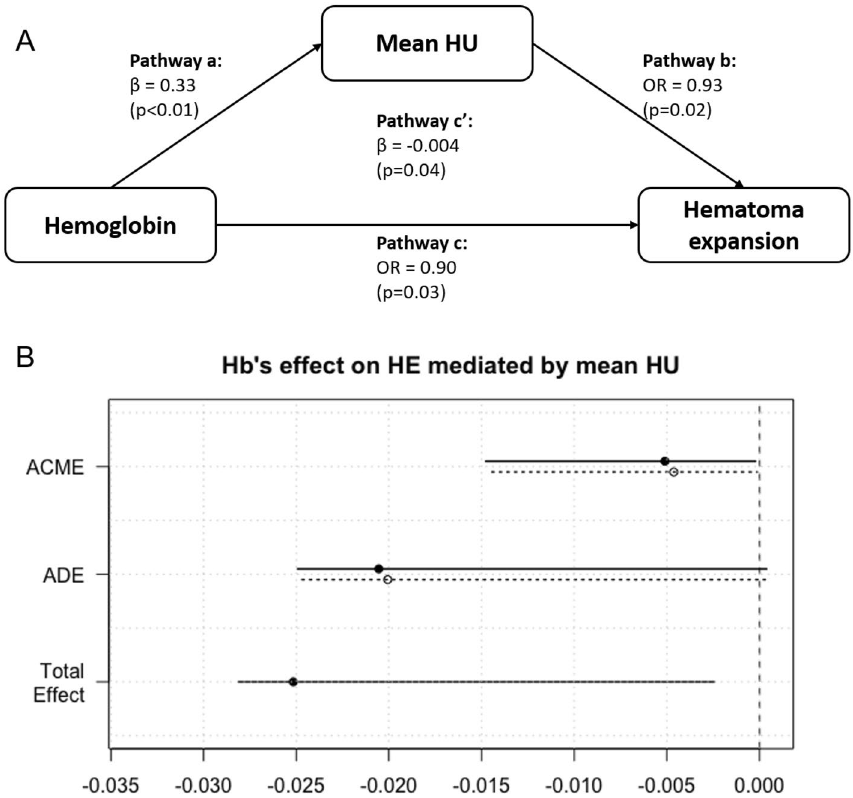
Figure 3. Mediation analysis of association between hemoglobin and HE with mediator mean HU. ( A ) Causal mediation effect of mean HU on the relationship between hemoglobin and hematoma expansion (HE). ( B ) Direct, indirect, and total effects of hemoglobin on HE mediated via the mean HU. HU, Hounsfield unit; β, coefficient; OR, odds ratio; ACME, average causal mediation effect; ADE, average direct